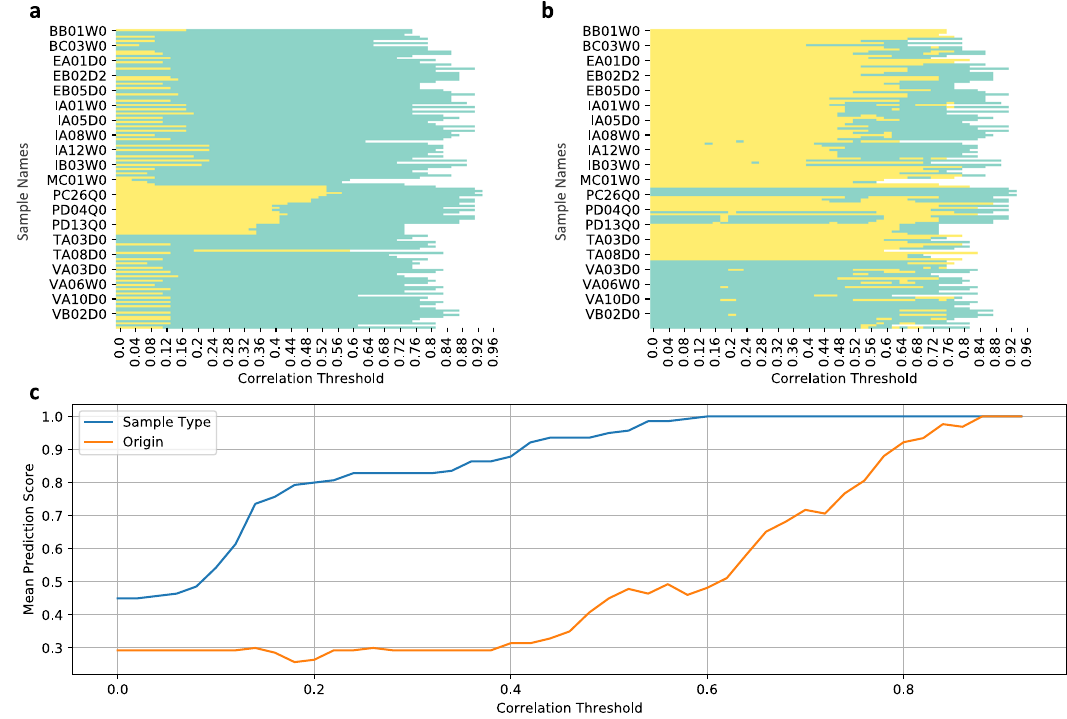
Fig. 4 Simple majority vote model to infer sample-type or origin of a node/sample. ( a ) Sample-type. Prediction result for inference of sample-type of all nodes (vertical axis) at continuously increasing correlation thresholds (horizontal axis): green indicates correct prediction, yellow indicates false prediction. ( b ) Origin. Prediction result for inference of country of origin of all nodes. Note : (1) Only few sample names (not all) are shown on the vertical axis to avoid clutter, however all samples are represented in the heatmaps. (2) At high correlation thresholds corresponding networks become sparse thus loosing edges/nodes, hence, sample-type/origin inference for some nodes may not be possible. These are shown by white portion in the heatmaps. ( c ) Mean prediction score of sample-type and country of origin as a function of increasing correlation thresholds. It is evident that, on average, sample-type can be predicted correctly at mid and higher correlation thresholds, while origin is correctly predicted at higher correlation threshold